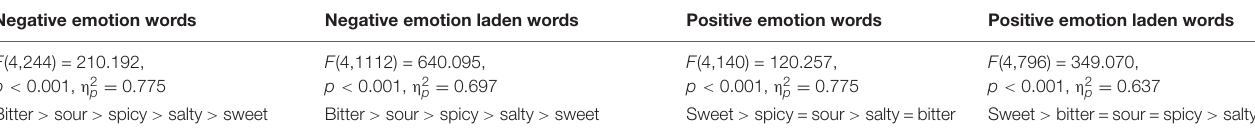
TABLE 4B | Results of repeated-measures ANOVA on five taste responses for four kinds of emotional words. Negative emotion words Negative emotion laden words Positive emotion